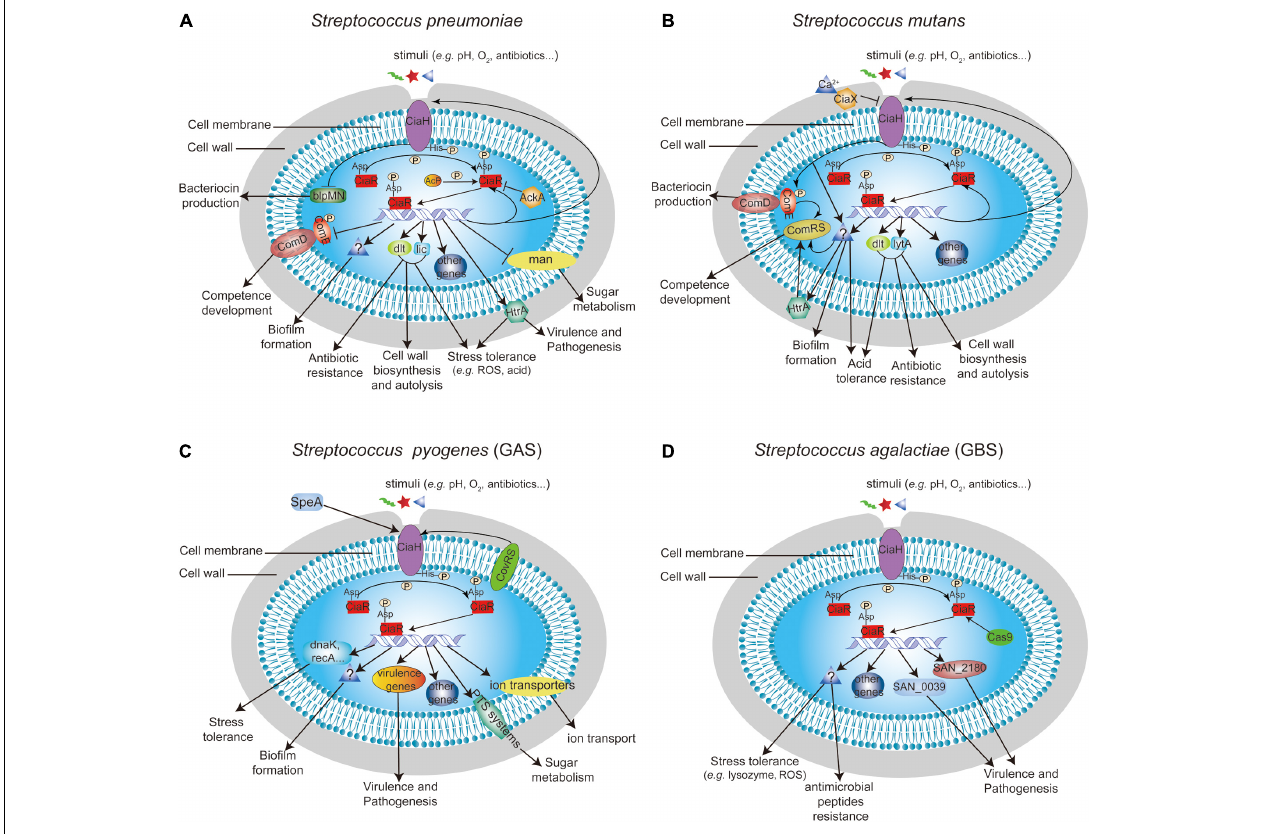
FIGURE 2 | Summary of the known function of CiaRH and its regulatory network in (A) S. pneumoniae , (B) S. mutans , (C) S. pyogenes , and (D) S. agalactiae